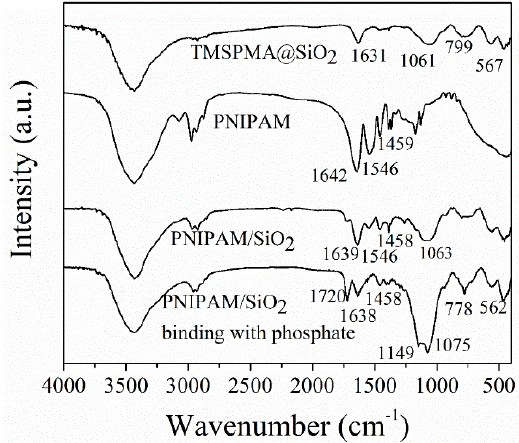
Figure 1. FT-IR spectra of TMSPMA@SiO 2 , PNIPAM microgels, PNIPAM/SiO 2 hybrid particles, and PNIPAM/SiO 2 hybrid particles binding with phosphate.